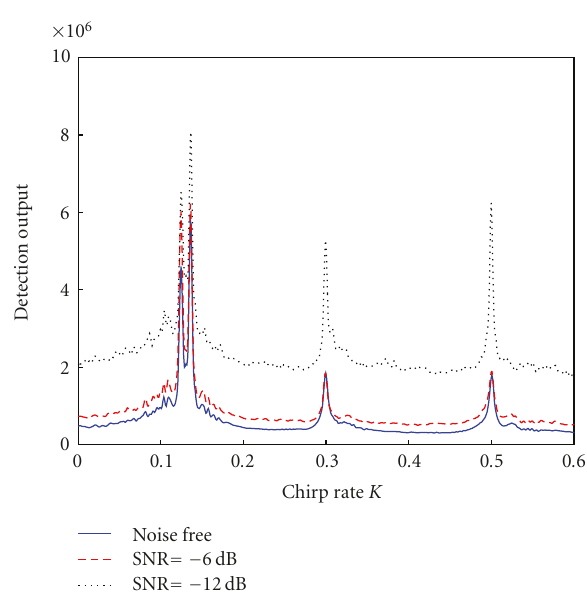
Figure 3: The detection output of multicomponent LFM-signal using 4th-power modulus form. Solid line: SNR = ∞ . Dashed line: SNR = − 6dB. Dotted line: SNR = − 12 dB.